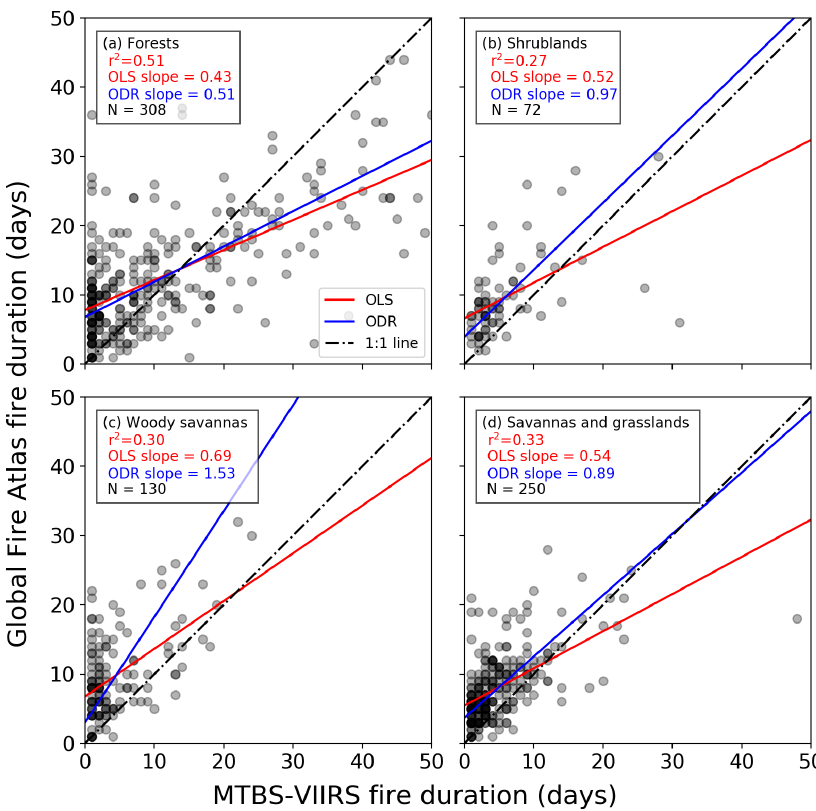
Figure 6. Comparison of fire duration estimates from the Global Fire Atlas and the combination of VIIRS active-fire detections within MTBS fire perimeters for the continental US (2012–2015). (a) Forests, (b) shrublands, (c) woody savannas, and (d) savannas and grasslands. Red lines indicate the slope between both datasets based on ordinary least squares (OLS) with corresponding r 2 values, while blue lines are based on orthogonal distance regression (ODR). For the scatterplots, darker gray or black indicates a greater density of points. This comparison was made for a subset of MTBS and Global Fire Atlas perimeters using selection criteria for perimeter overlap and VIIRS active-fire detections described in Sect.